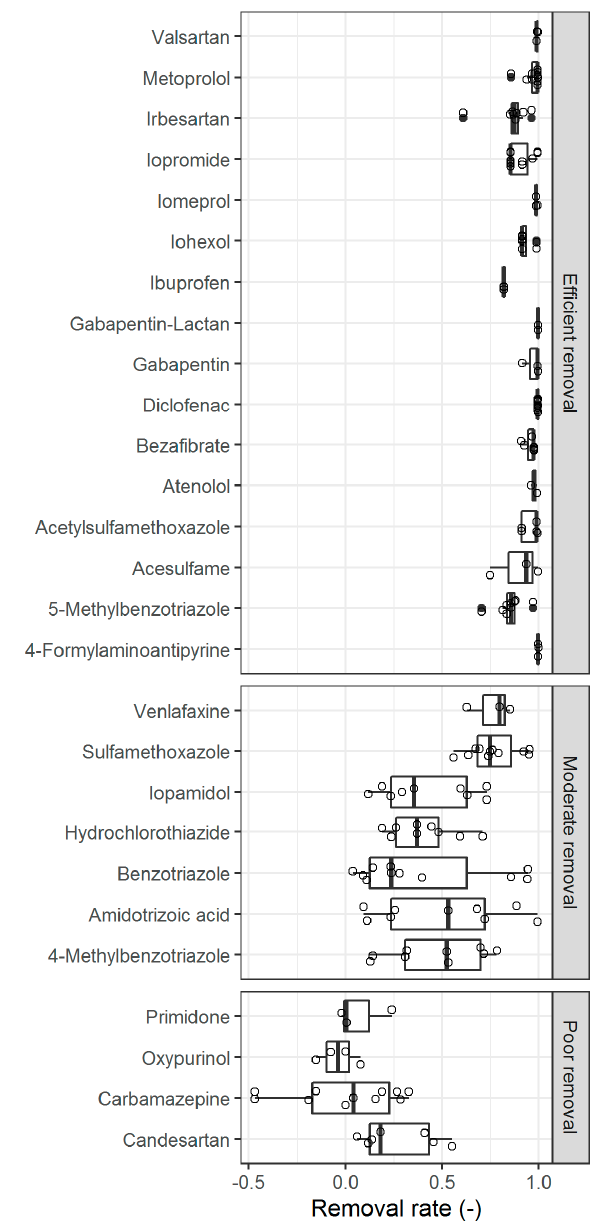
Figure 4. Removal rates (-) of CECs for all 11 scenarios conducted. The removal efficiencies are divided into three categories: efficient (>0.8), moderate (0.3–0.8) and poor (<0.3). White dots indicate measured values, and boxplots show median, range, quartiles and outliers (black dots). Values below detection limit (DL) were regarded with DL/2.